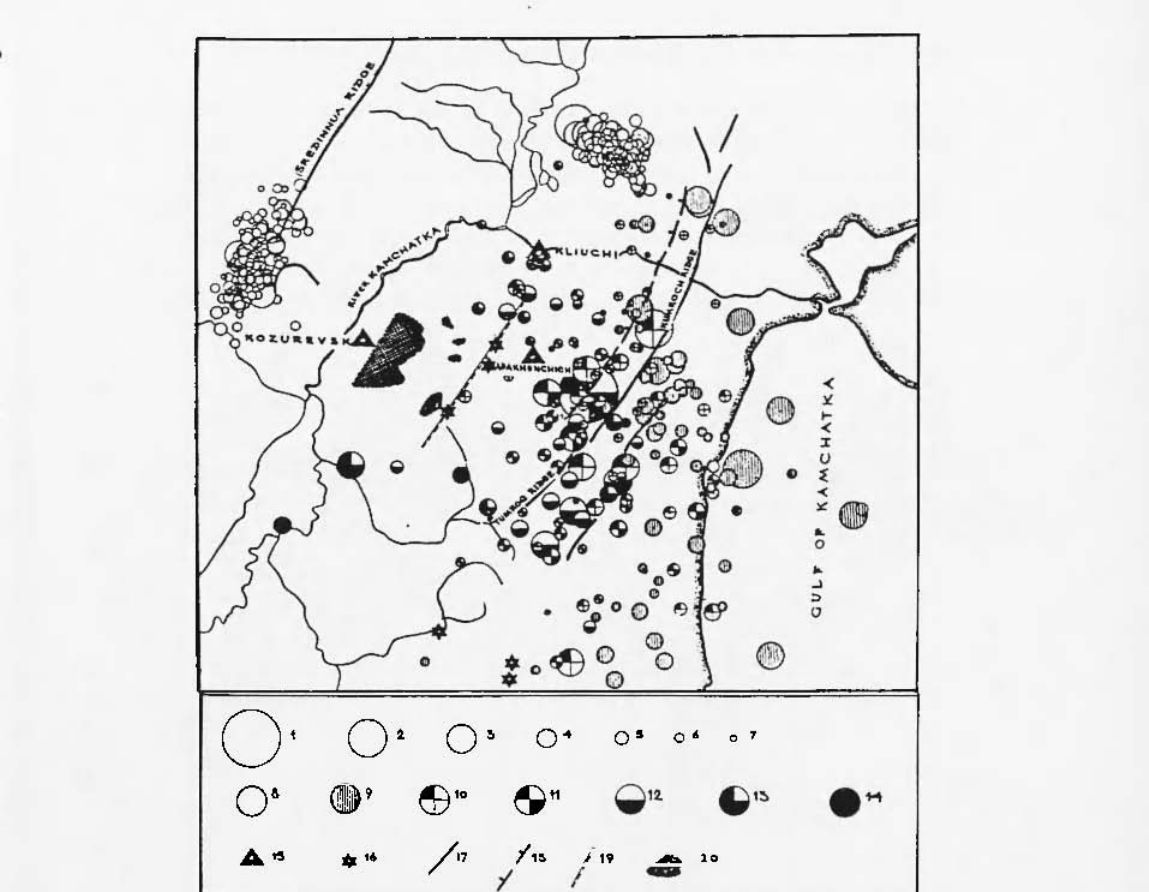
Fig. 13. - ?lIap of thc cpiccntcrs of dccp-foCU8 cal'thquakcs in thc vicinity of thc KlilLchevskaya gruup of volcanoe!'!, Kamchatka, fur thc timo interval 1964 tu 1968 [from Fil'stov and Shirokov